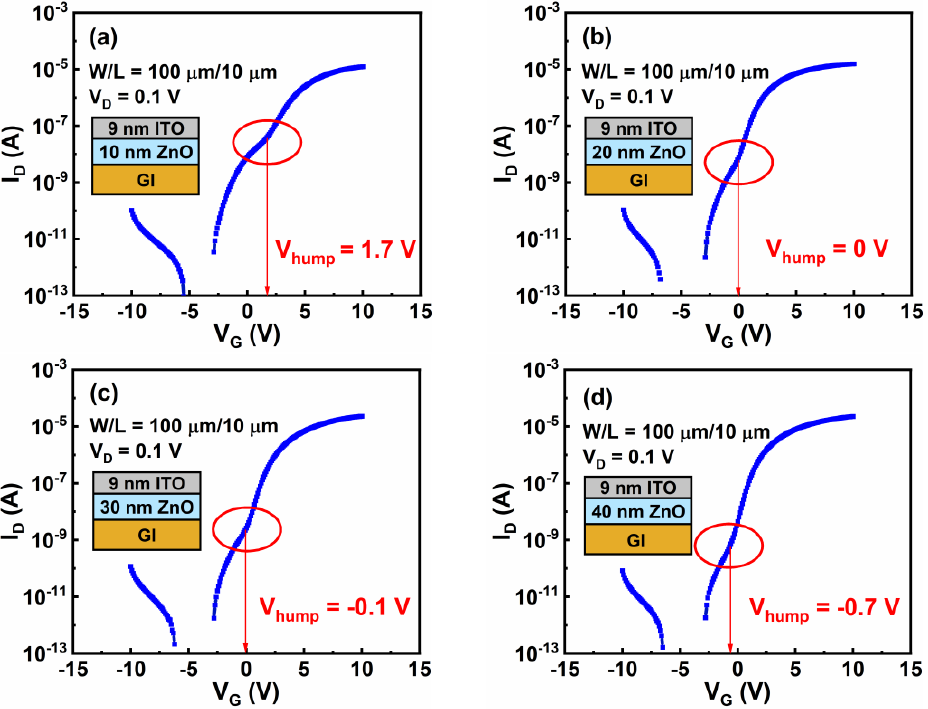
Figure 6. I D –V G curves for group A TFTs. The t ZnO values are ( a ) 10 nm, ( b ) 20 nm, ( c ) 30 nm, and ( d ) 40 nm. The t ITO value is 9 nm. Table 2. Electrical parameters of ZnO/ITO TFTs, including µ FE , V hump , and V ON .